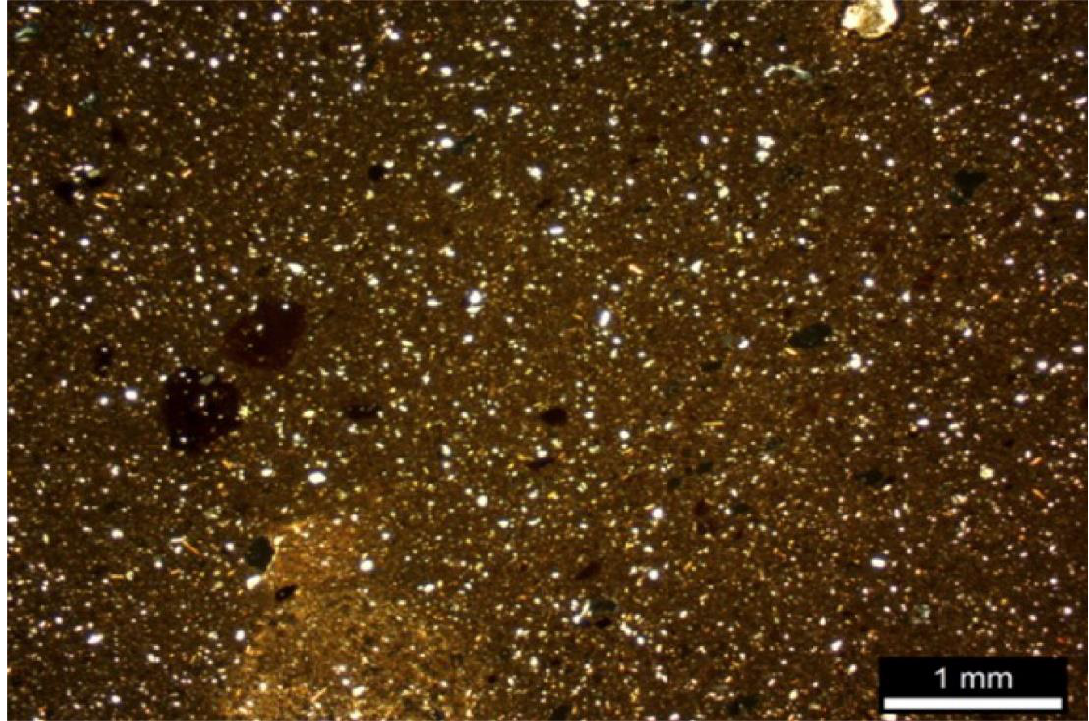
Figure 13. Photomicrograph of sample ALM 12/32, a typical SAR 1 composition under crossed polars. Yellowish feature in the lower left of the image is part of an incompletely homogenized marl. Image by William Gilstrap.